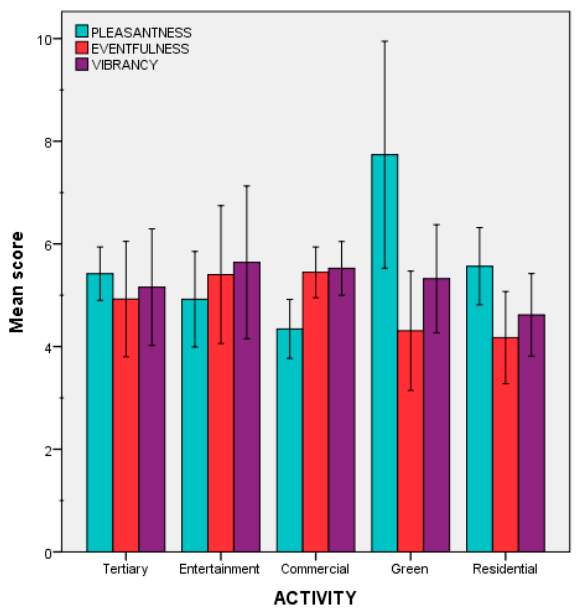
Figure 7. Mean scores for pleasantness, eventfulness and vibrancy (Error bars: 95% CI).